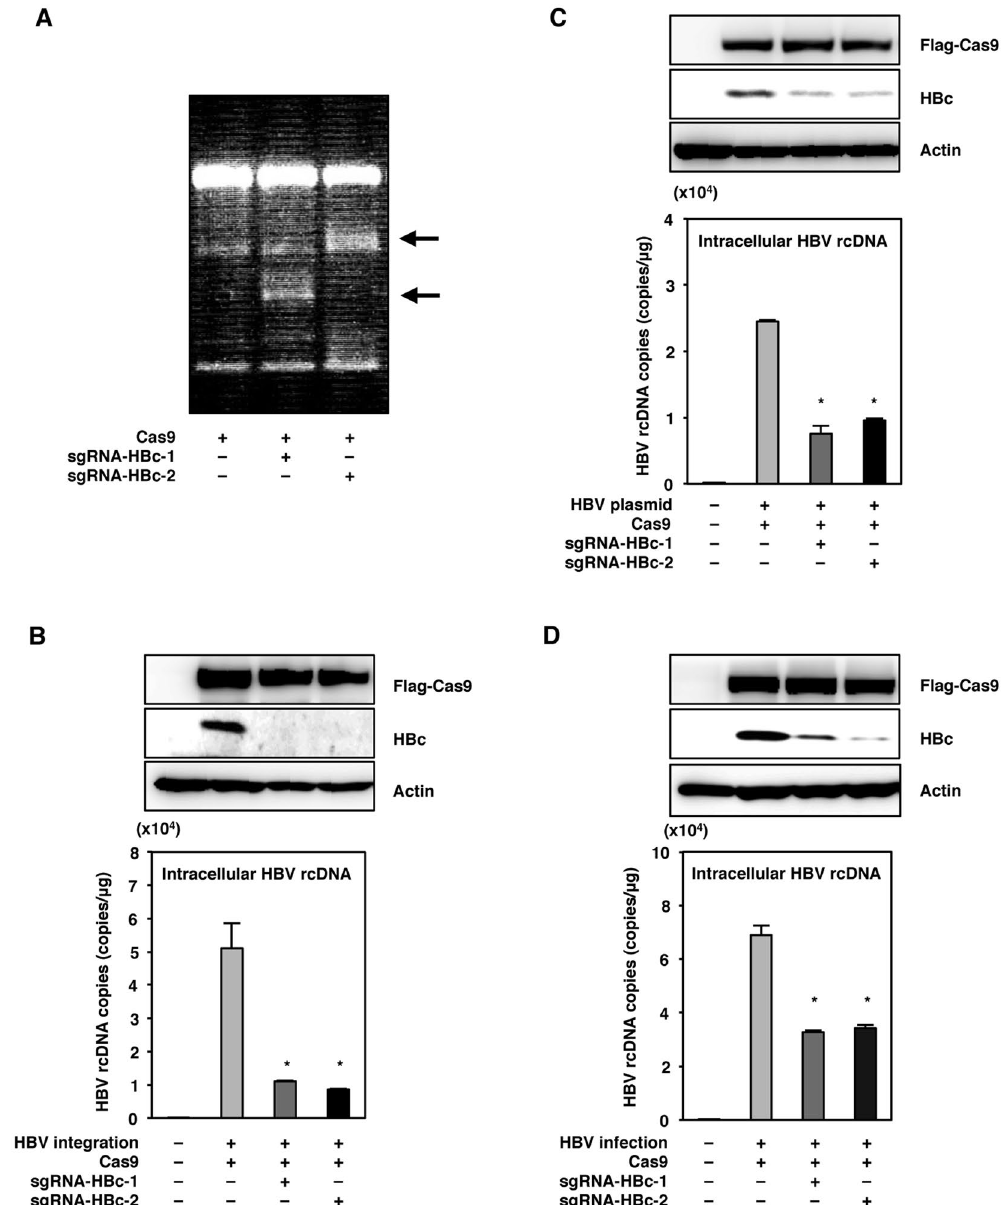
Figure 2. The expression of Cas9 with the sgRNAs can cleave the target HBV genome and suppress HBV replication. ( A ) Cas9 and either sgRNA-HBc-1 or sgRNA-HBc-2 were lentivirally transduced into HepG2.2.15.7 cells. Total DNA was collected at 5 days post-transduction, and mutations of the HBV genome in HepG2.2.15.7 cells were detected by a surveyor assay. The arrows indicated the surveyor digestion products. ( B ) HepG2.2.15.7 cells transduced with Cas9 and the sgRNAs were collected at 5 days post-transduction, and the expression of HBc was determined by immunoblotting. Intracellular HBV rcDNAs were extracted at 5 days post-transduction and quantified by qPCR. ( C ) Huh7 cells transduced with Cas9 and the sgRNAs were transfected with a plasmid containing 1.3-fold-overlength genome of HBV at 3 days post-transduction. Cell lysates were collected at 3 days post-transfection, and the expression of HBc was determined by immunoblotting. Intracellular HBV rcDNAs were extracted at 3 days post-transfection and quantified by qPCR. ( D ) HepG2-hNTCP-C4 cells expressing Cas9 and the sgRNAs by lentivirus vector were infected with HBV derived from the supernatants of HepAD38.7 cells at 3 days post-transduction. Cell lysates were collected at 10 days post-infection, and the expression of HBc protein was determined by immunoblotting. Intracellular HBV rcDNAs were extracted at 10 days post- infection and quantified by qPCR. * p < 0.01 vs. the results for control cells. (full-length gels are presented in Supplementary